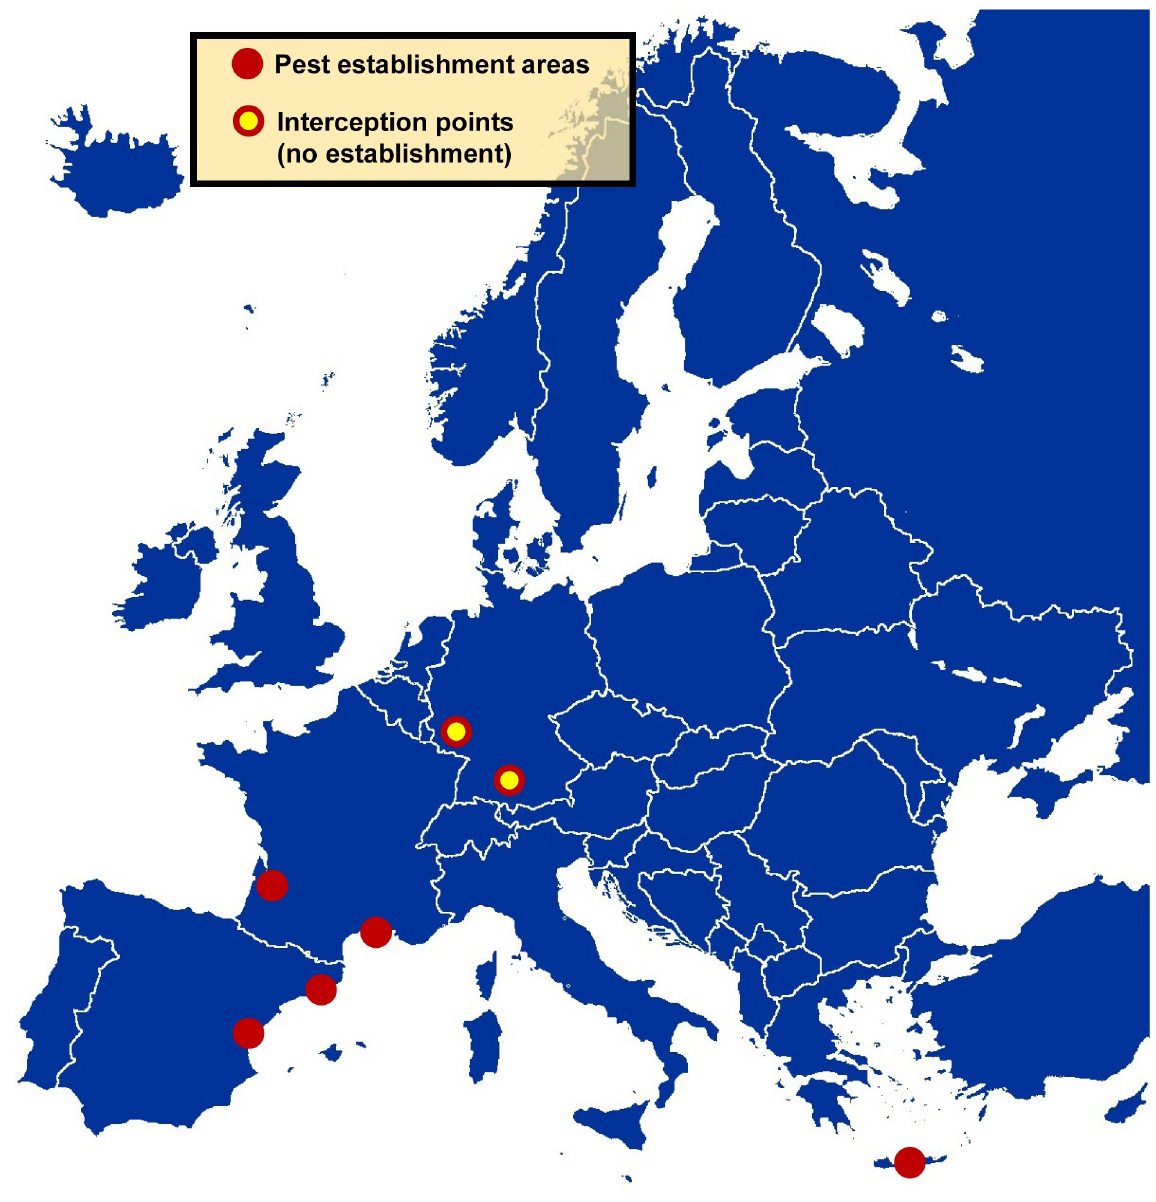
Fig 2. Xylotrechus chinensis in Europe up to July 2020. Source map reprinted from https://commons.wikimedia.org/wiki/File:Europe_map.png under a CC BY license, with permission from Wiki-vr, Public domain, via Wikimedia Commons. 30 November 2013.